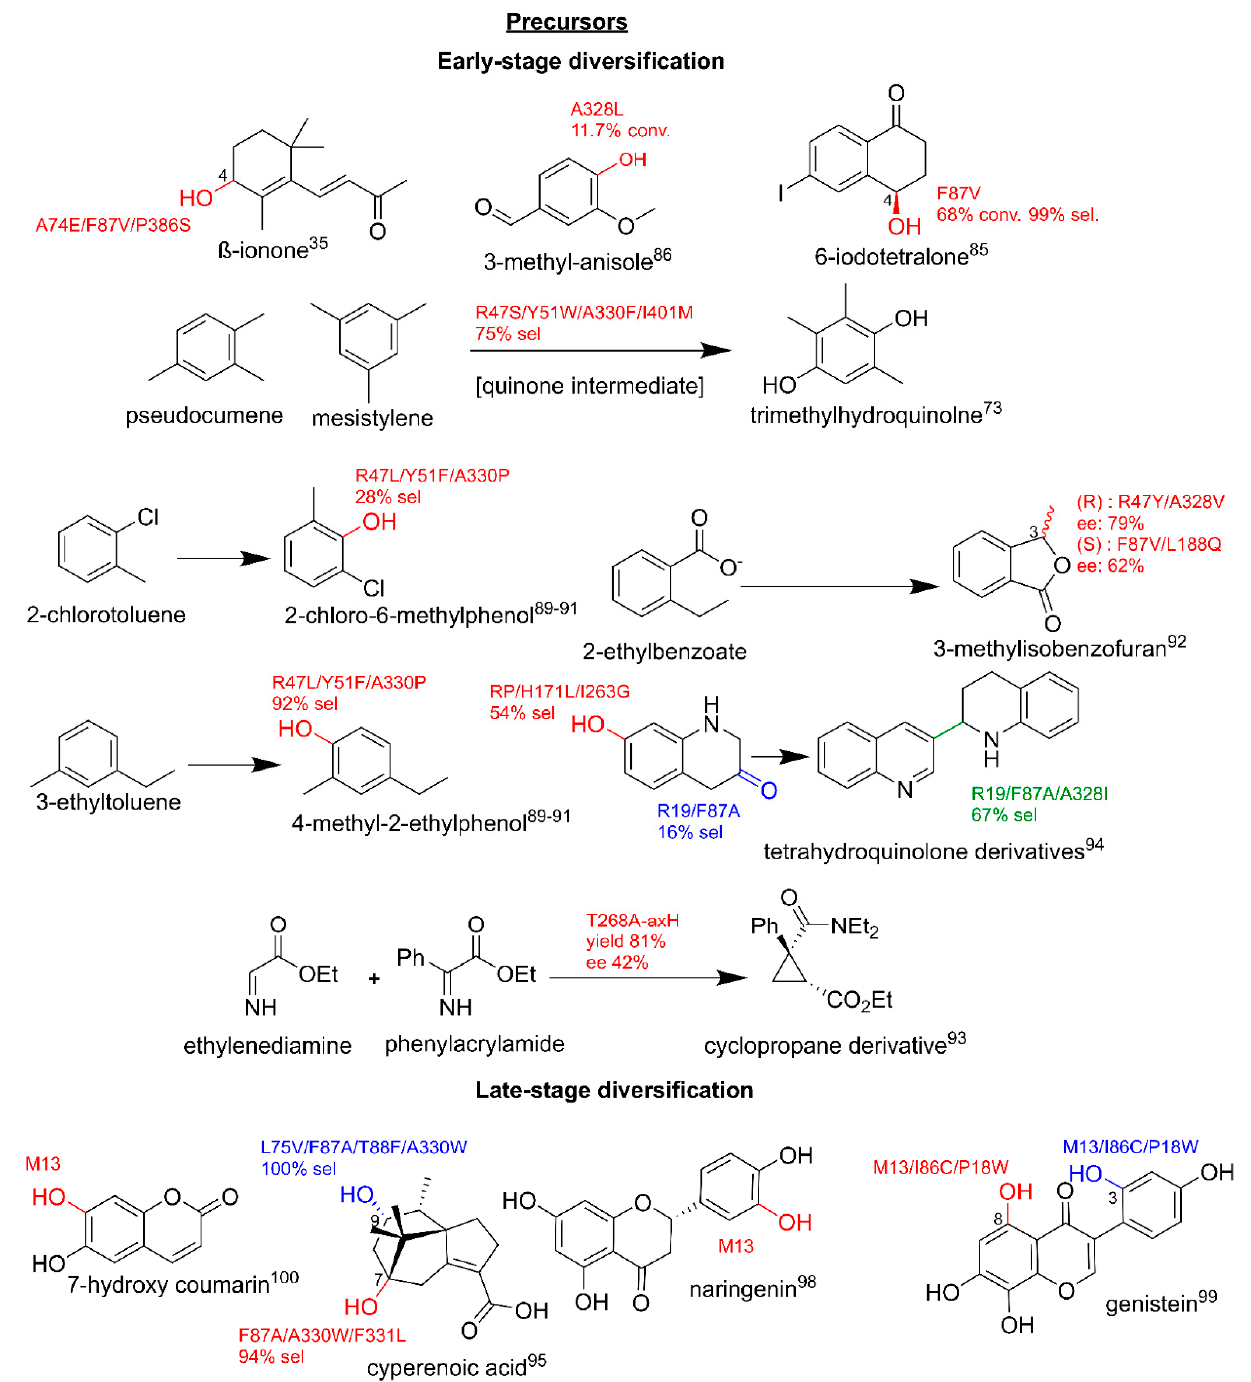
Figure 5. BM3-mediated pharmaceutical precursor production. Parent compounds are in black. Modifications are in red, blue and green with related variants that target the compounds. Conv, conversion; sel, selectivity; ee, enantiomeric excess. Literature references are in superscript.